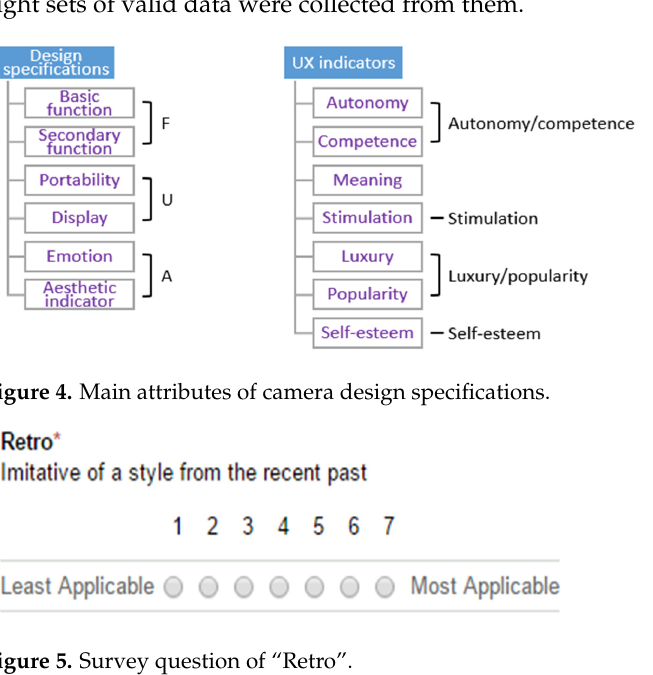
Figure 5. Survey question of